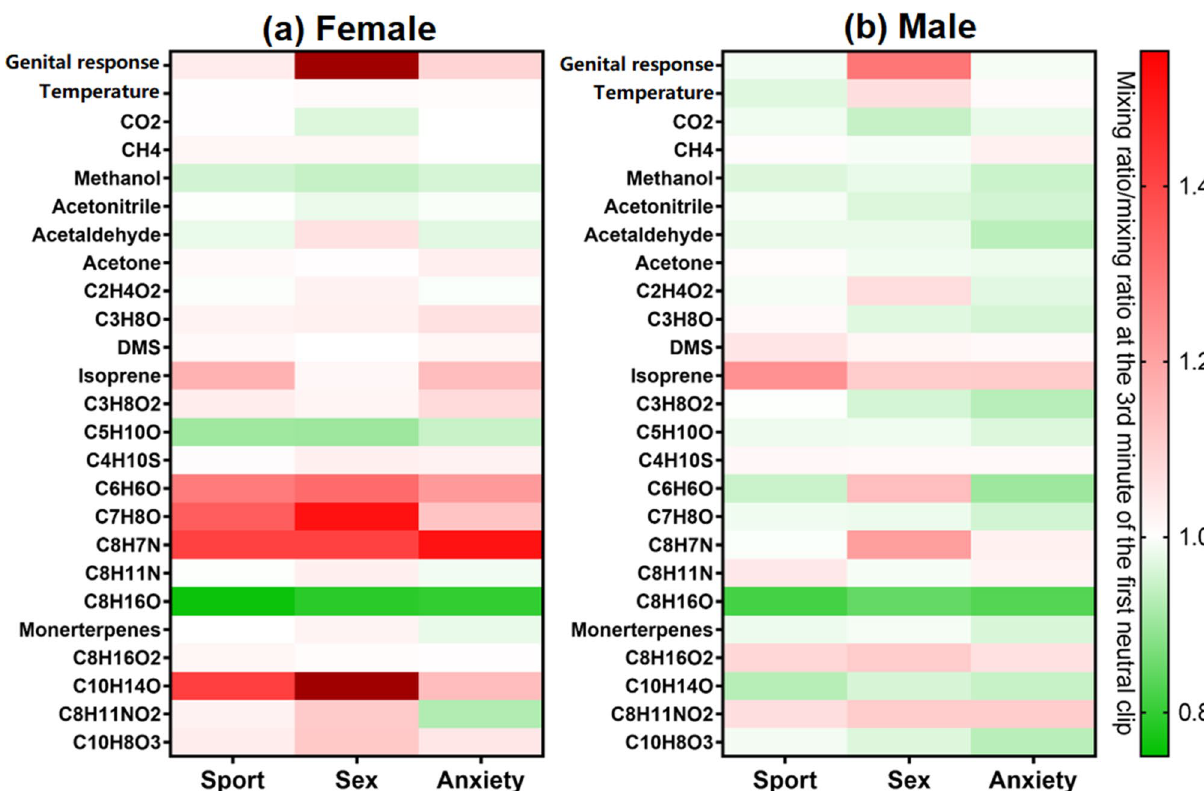
Figure 3. Mean levels of normalized genital response (male: penile circumference; female: vaginal pulse amplitude), temperature (male: glans of the penis; female: clitoris) and selected VOCs in exhalation of ( a ) female participants and ( b ) male participants during each film